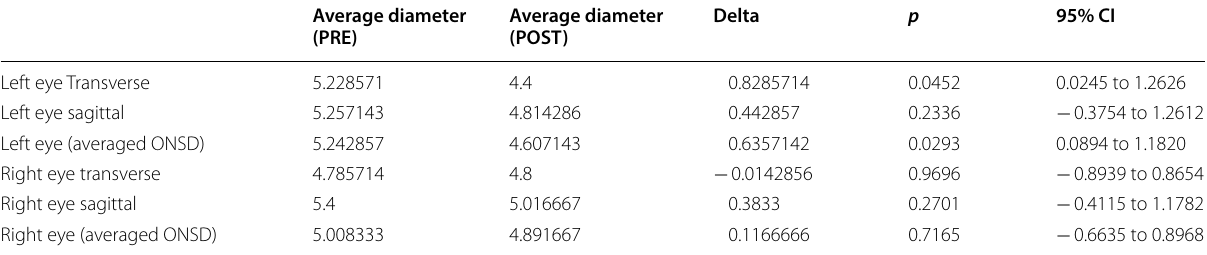
Table 3 Comparison of participant optic nerve sheath diameter, by plane of measurement, pre-lumbar puncture compared to post-lumbar puncture, for participants with elevated intracranial pressure (opening pressure > 25